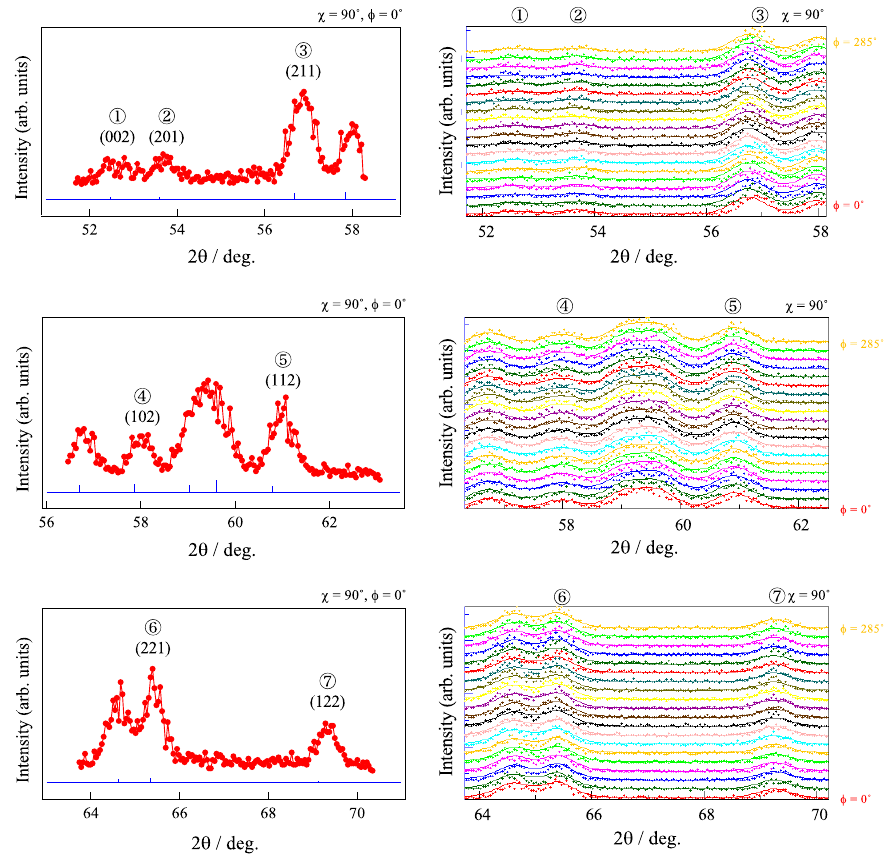
Figure 4. Typical neutron diffraction patterns obtained in the as-sintered sample. The blue lines in the left portion of the figure shows the expected peak positions of cementite. Each solid line in the right portion of the figure is the result of peak fitting.